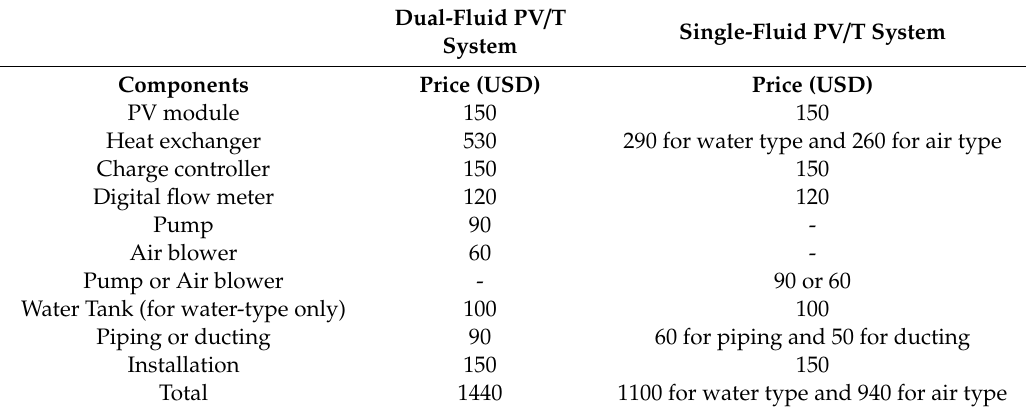
Table 3. Total Initial Investment.